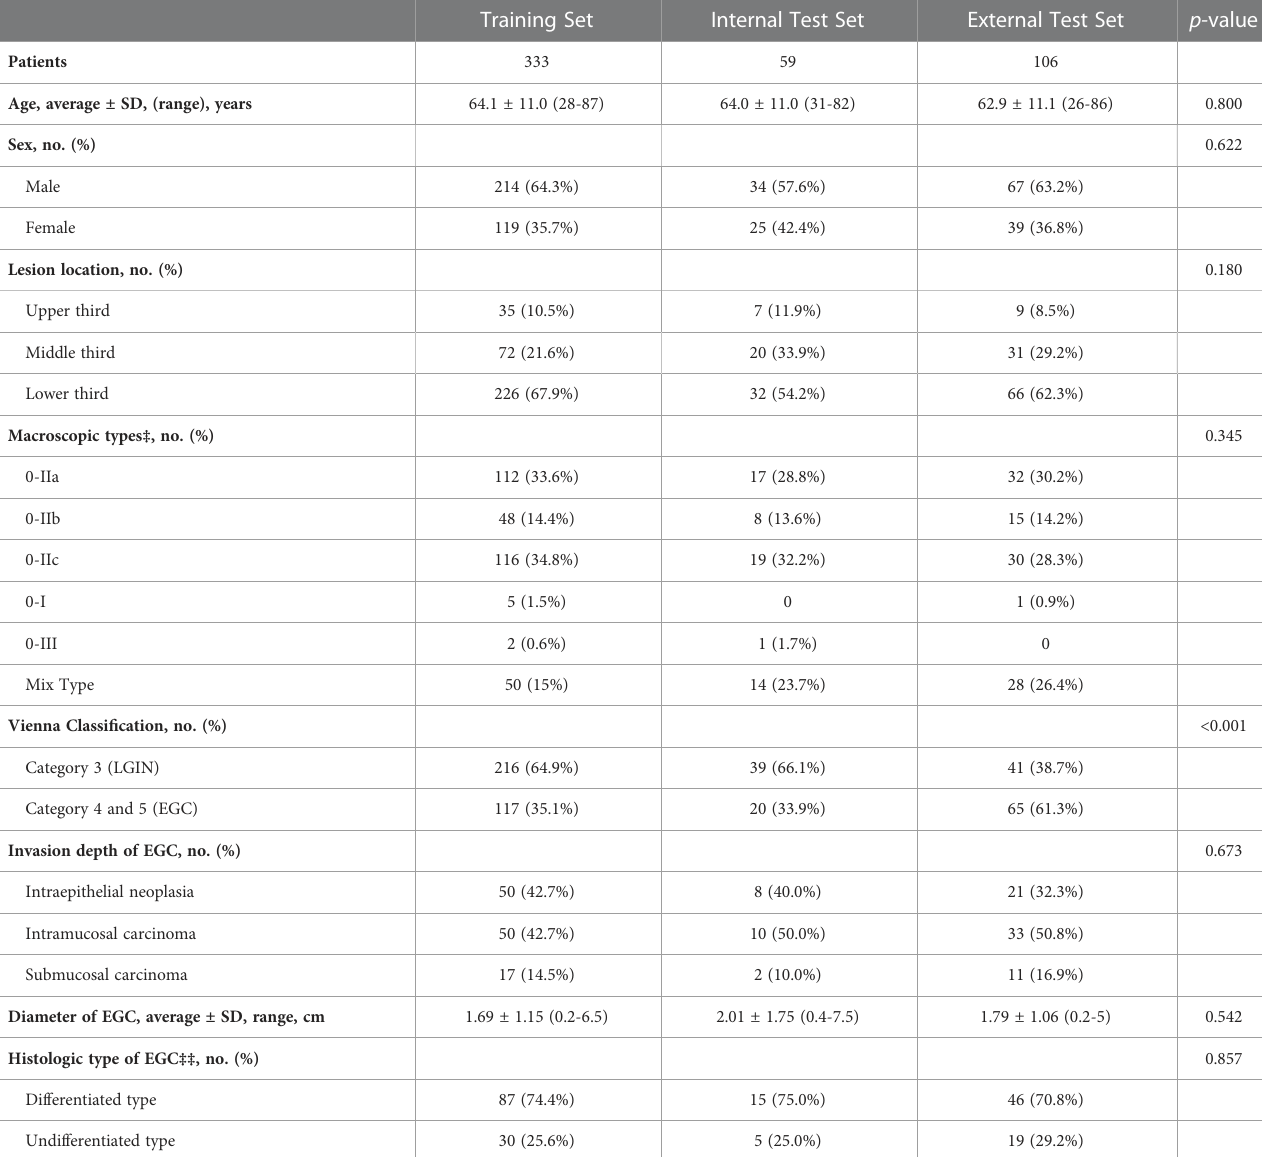
TABLE 1 Clinical characteristics of patients in the training set and test sets. Training Set Internal Test Set External Test